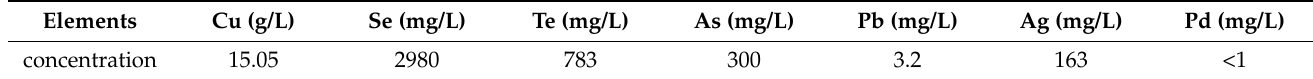
Table 7. Analysis of pregnant solution according to optimal condition of Se/Te separation.